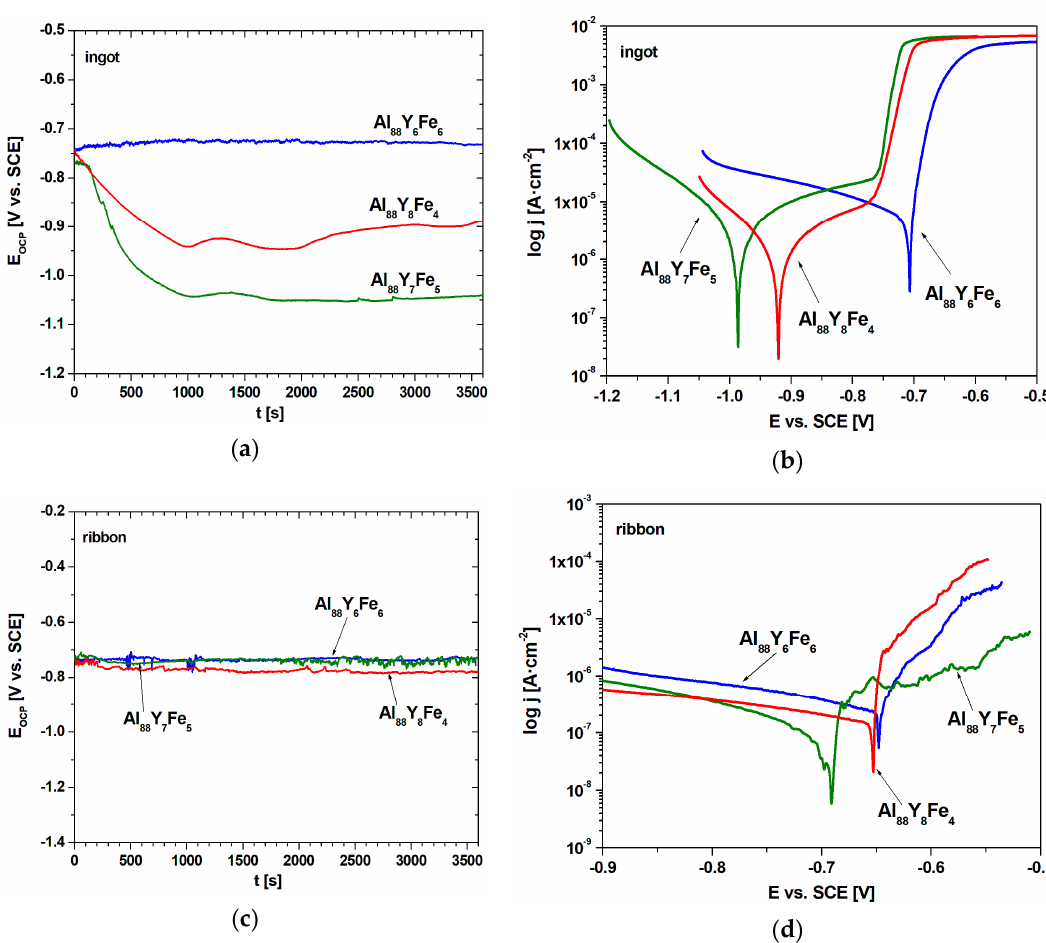
Figure 7. Changes of the open-circuit potential with time ( a , c ) and polarization curves ( b , d ) in 3.5% NaCl solution at 25 °C of ingots ( a , b ) and ribbons ( c , d ).